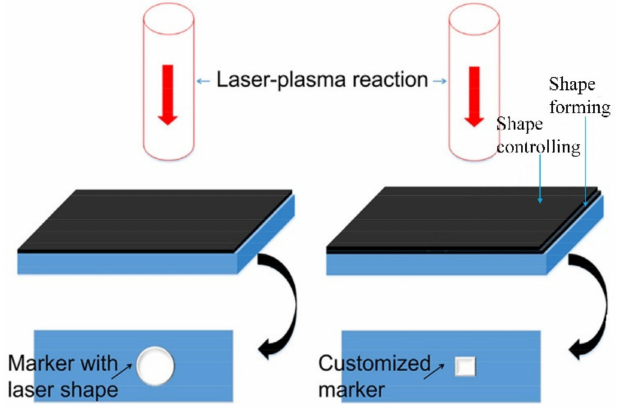
Figure 14. The schematic diagram of LSM